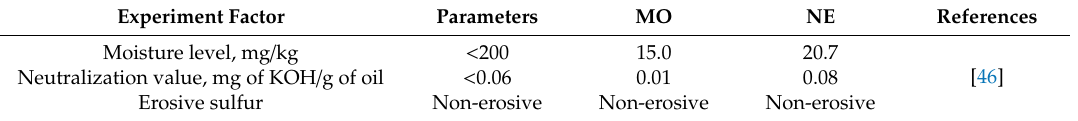
Table 14. Chemical characteristics of di ff erent insulating